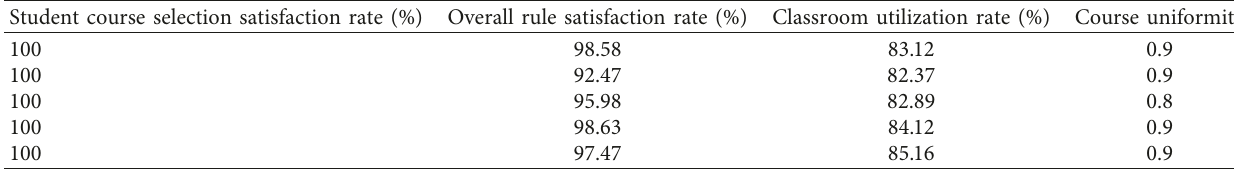
Table 3: Schedule efficiency.